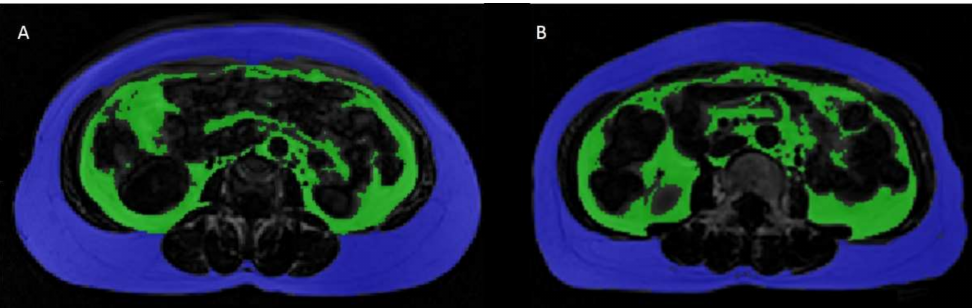
Figure 3. Images from two participants from the Asian cohort with similar VAT/SAT ratios (VAT/SAT = 0.33) and different BMI ( A : BMI = 24.6 kg/m 2 , B : BMI = 22.1 kg/m 2 ). Abbreviations: BMI: Body mass index; SAT: Subcutaneous adipose tissue; VAT: Visceral adipose tissue.